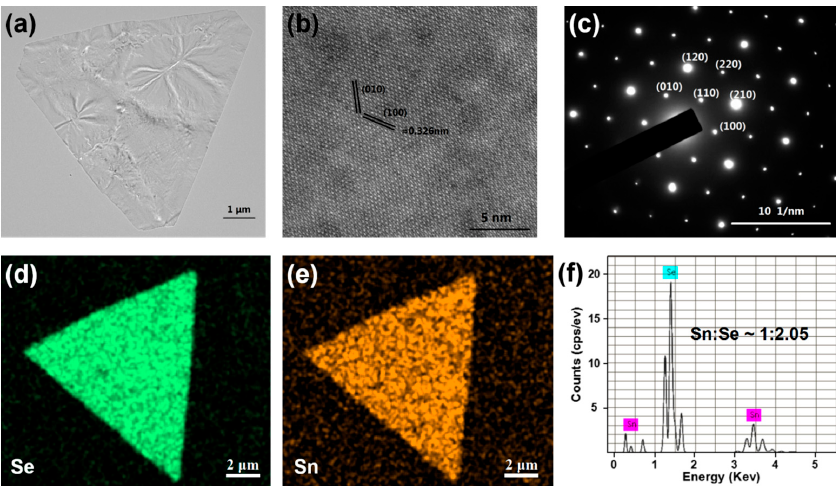
Figure 2. Transmission electron microscopy (TEM) and energy dispersive X-ray spectroscopy (EDX) characterization of SnSe 2 nanoflakes. ( a ) Low-magnification TEM image of the typical SnSe 2 nanoflake; ( b ) The corresponding high-resolution TEM image of the SnSe 2 nanoflake in (a); ( c ) The selected area electron diffraction pattern of the SnSe 2 single crystal; ( d , e ) The Se and Sn elemental mapping of the SnSe 2 nanoflakes on mica, respectively; ( f ) EDS spectrum of the as-grown SnSe 2 nanoflake on mica.